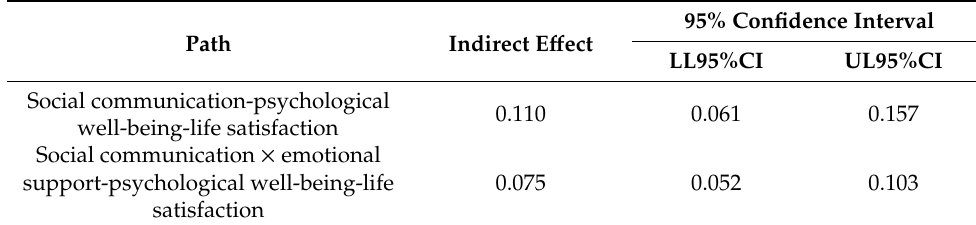
Table 4. Bootstrap analysis